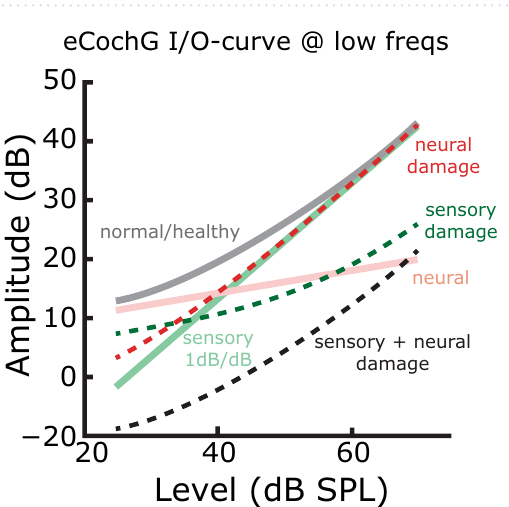
Figure 7. Effects of exposure to an intense, 4-kHz tone on RW- and remote-eCochG. ( A – C ) Average (± 1 s.d.) change in DP amplitude after exposure to an intense, 4-kHz tone (100 dB SPL, 15 min). DPs were evoked with L 1 = L 2 = 60 dB SPL and f 2 /f 1 = 1.25, and simultaneously measured as ( A ) DPOAEs in the ear canal and as DPs in ( B ) RW-eCochG and ( C ) remote-eCochG. Mean DP changes from A–C are superimposed in ( D ) to aid their comparison. Vertical gray bars indicate 4 kHz, either as stimulus, i.e., f 2 or DP frequency. ( E ) Averaged (± 1 s.d.) change in eCochG amplitudes for the f 2 stimulus tone. The green and red line are for RW- and remote-eCochG, respectively. ( F – J ) Same layout as ( A – E ), but for L 1 = L 2 = 80 dB SPL.